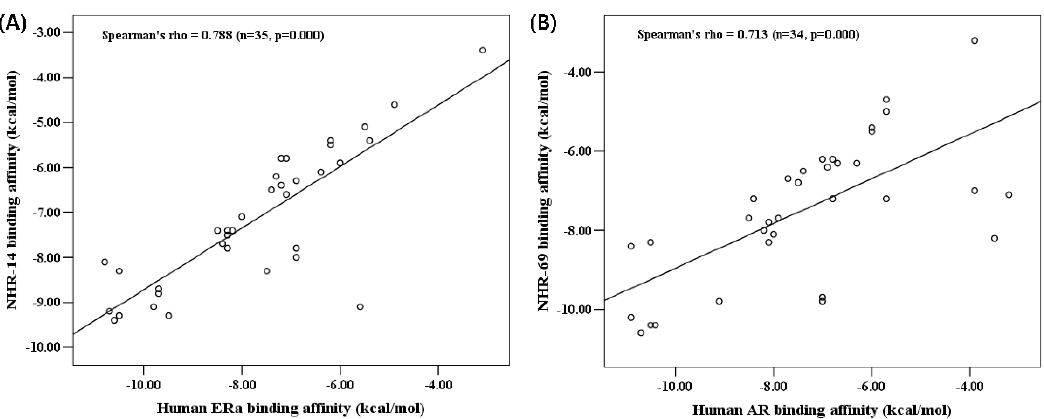
Figure 2. Correlation analysis of binding affinity. Correlation plot between ( A ) human estrogen receptor alpha and its homology model of C. elegans , NHR-14 and ( B ) human androgen receptor and its homology model of C. elegans , NHR-69. Correlation analysis was performed by Spearman’s rank-order correlation.